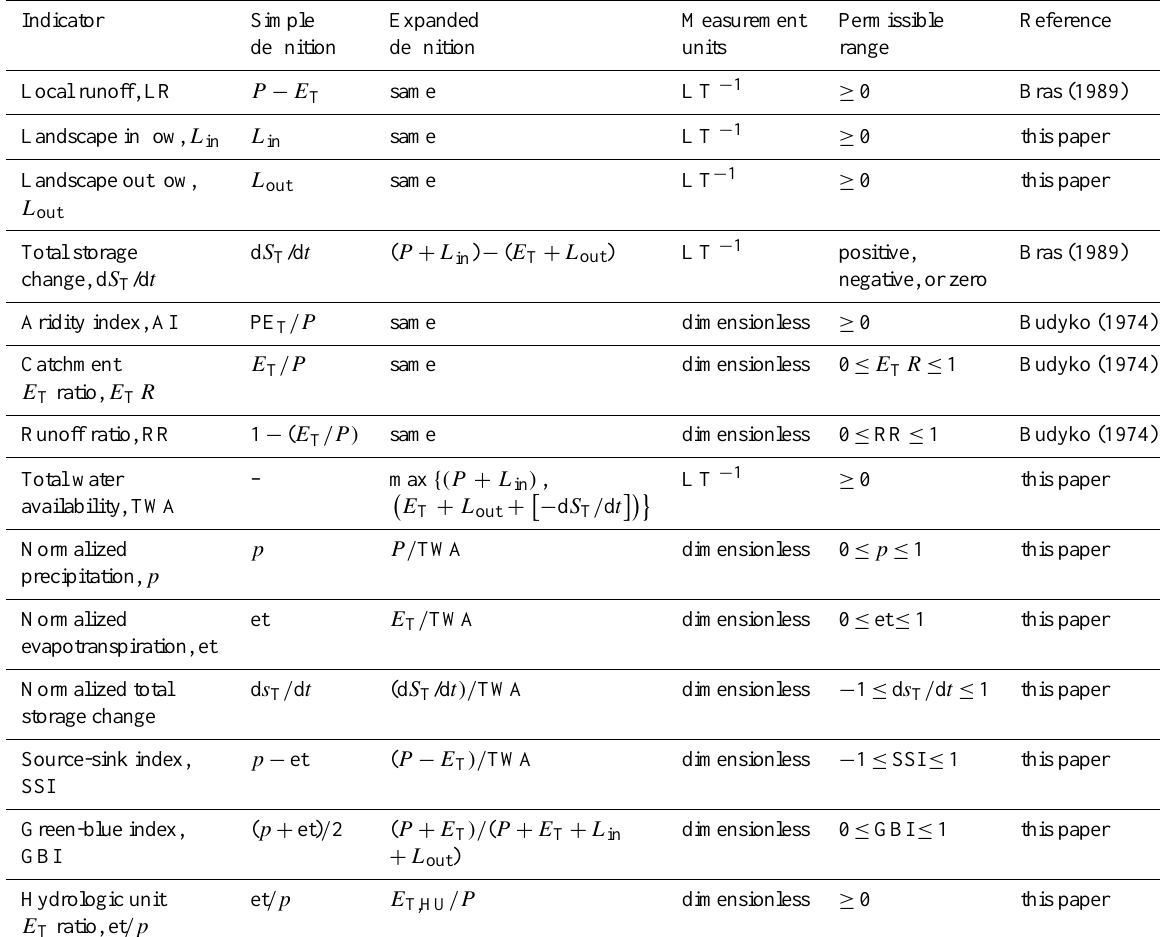
Table 2. Indicators of terrestrial water availability. P , precipitation; E T , evapotranspiration; PE T , potential evapotranspiration. Landscape inflows and outflows ( L in , L out ) include both surface and groundwater flows (Fig. 1a). All length per time units (LT − 1 ) are equivalent to L − 3 L − 2 T − 1 , where L 2 refers to the area of the local HU that is receiving or donating water. LR is the mean local runoff during a specified long-term period; other indicators may be defined for a specified period, or time step, of any